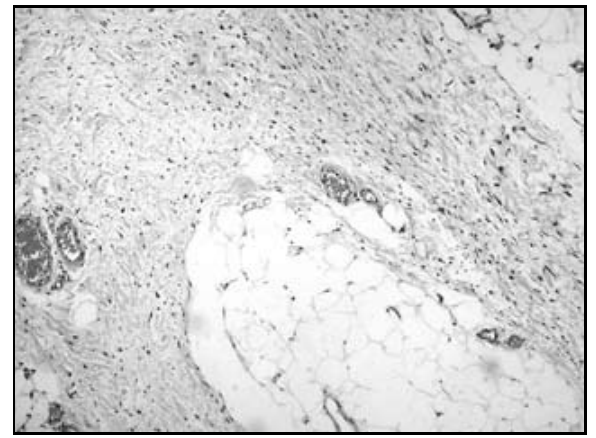
Figura 4 – Tecido adiposo aprisionado pelo tumor (HE